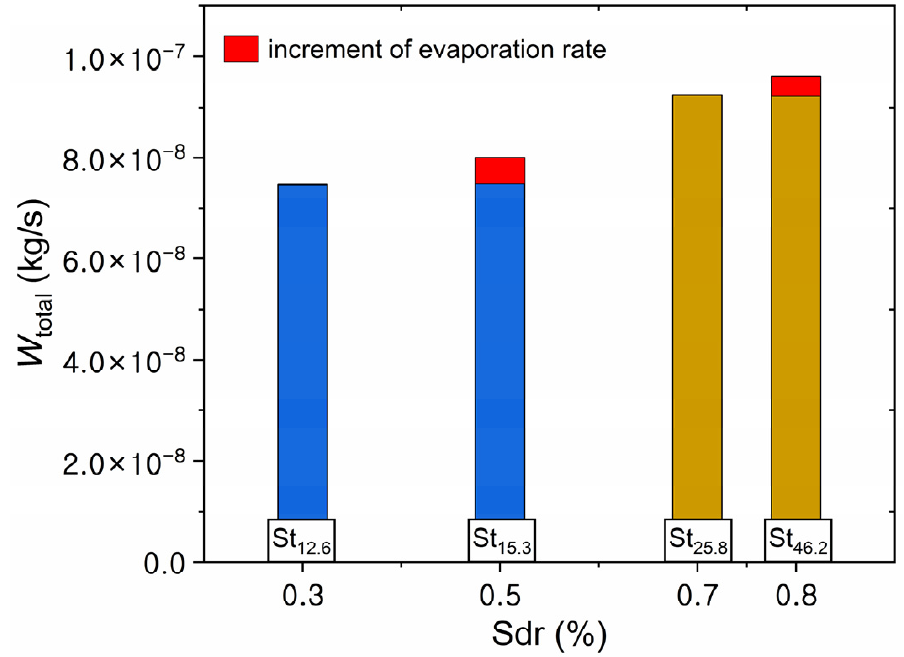
Figure 7. Total evaporation rate of water droplets versus Sdr parameter (increment of surface area due to increased roughness) for St 12.6 , St 15.3 , St 25.8 , and St 46.2 surfaces.